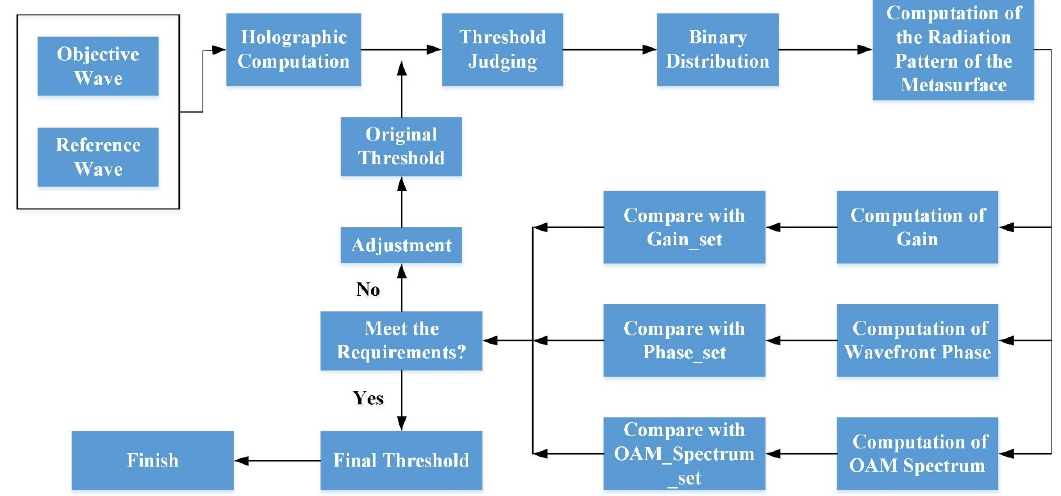
Figure 4. Calculation flow chart for determining the threshold.